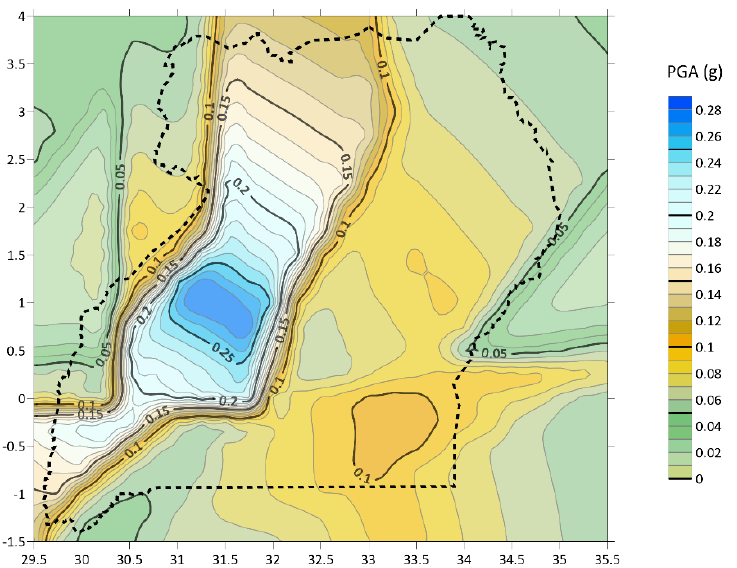
Figure 8. Seismic hazard map of PGA contours for a probability 10% exceedance in 5 years.